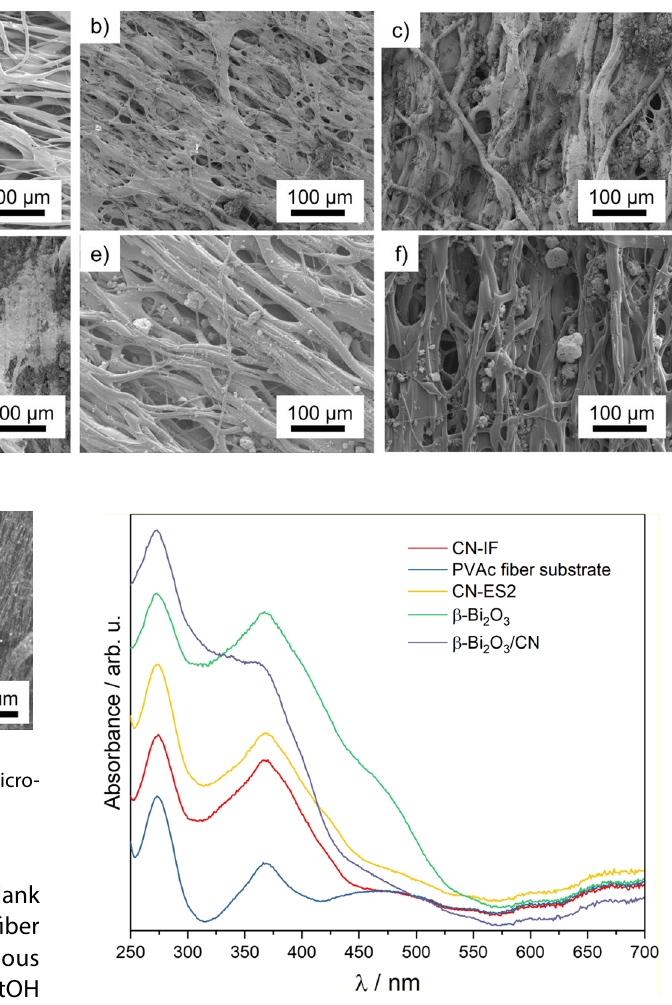
Fig. 4 Diffuse UV–Vis reflectance spectra of CN-IF , a PVAc fiber sub- strate, CN-ES2 , β-Bi